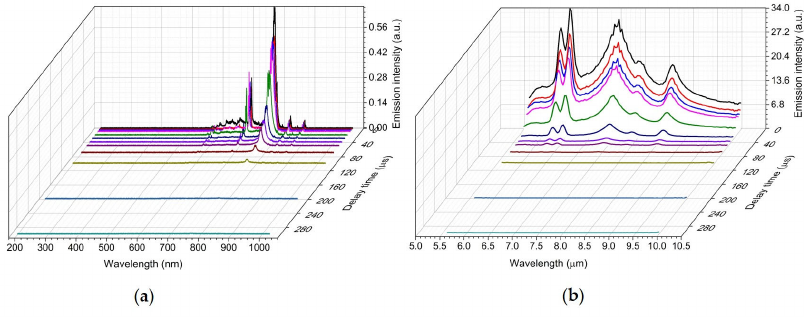
Figure 7. Simultaneous UV/Vis/NIR ( a ) + LWIR ( b ) LIBS spectrum of an acetaminophen tablet meas- ured at a delay time of 1 µs, 3 µs, 6 µs, 10 µs, 20 µs, 30 µs, 40 µs, 50 µs, 70 µs, 100 µs, 200 µs, and 300 µs.